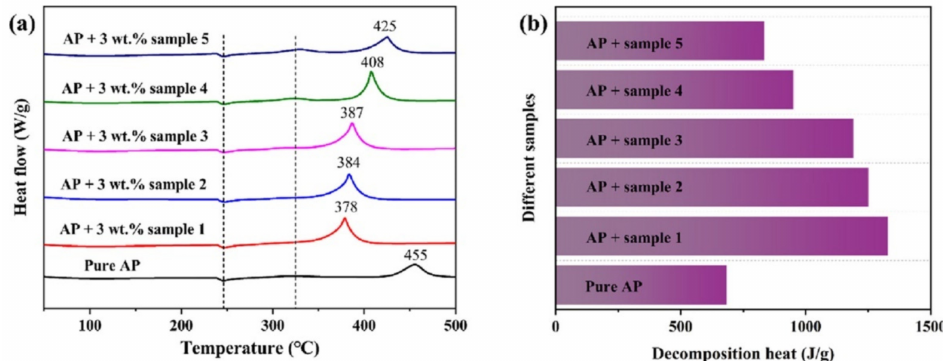
Figure 19. ( a ) DSC curves of AP thermal decomposition with and without the GO/Fe 2 O 3 nanocom- posite; ( b ) heat release during the decomposition of AP with and without catalysts. ( a , b ) Reproduced with the permission of ref. [99]. Copyright 2021, Langmuir. Sample 1 GO:Fe 2 O 3 = 1:10, Sample 2 GO:Fe 2 O 3 = 3:20, Sample 3 GO:Fe 2 O 3 = 3:10, Sample 4 GO:Fe 2 O 3 = 1:1, Sample 5 GO:Fe 2 O 3 =